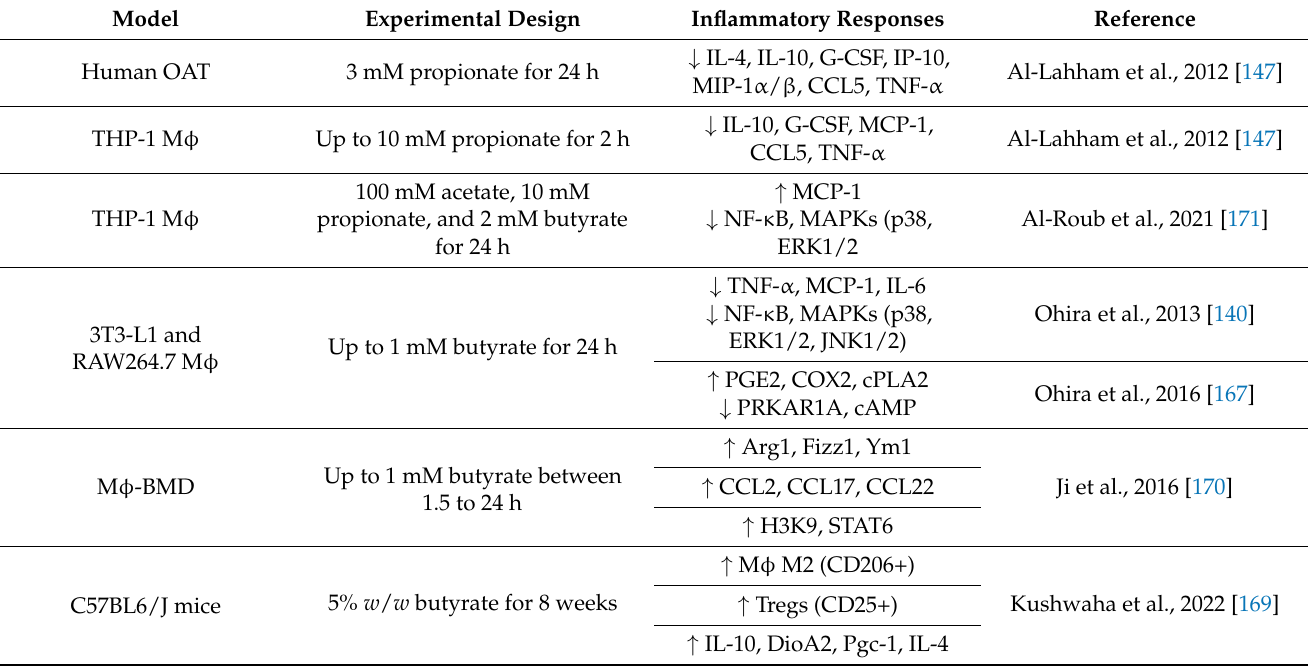
Table 3. Gut microbial-derived SCFAs influence adipose tissue